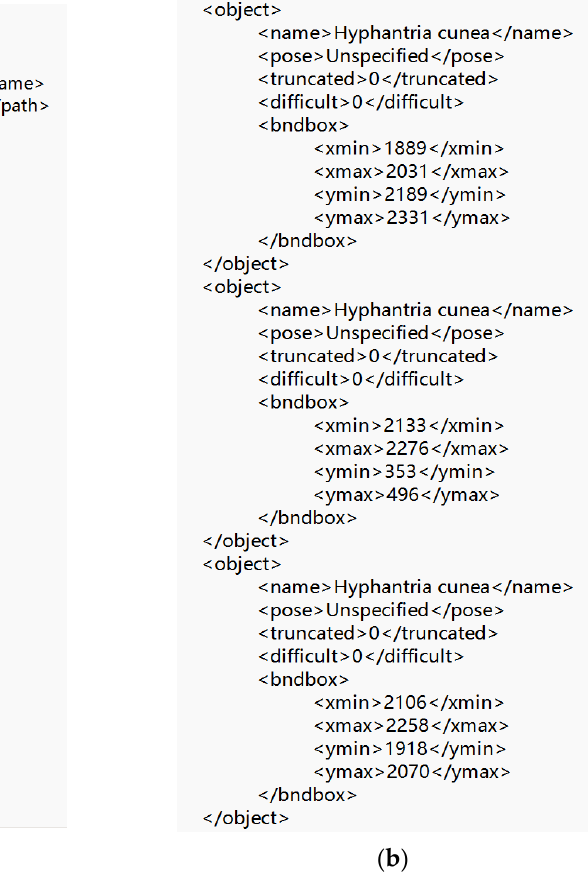
Figure 6. XML file tag information. ( a ) XML file tag information 1; ( b ) XML file tag information 2.